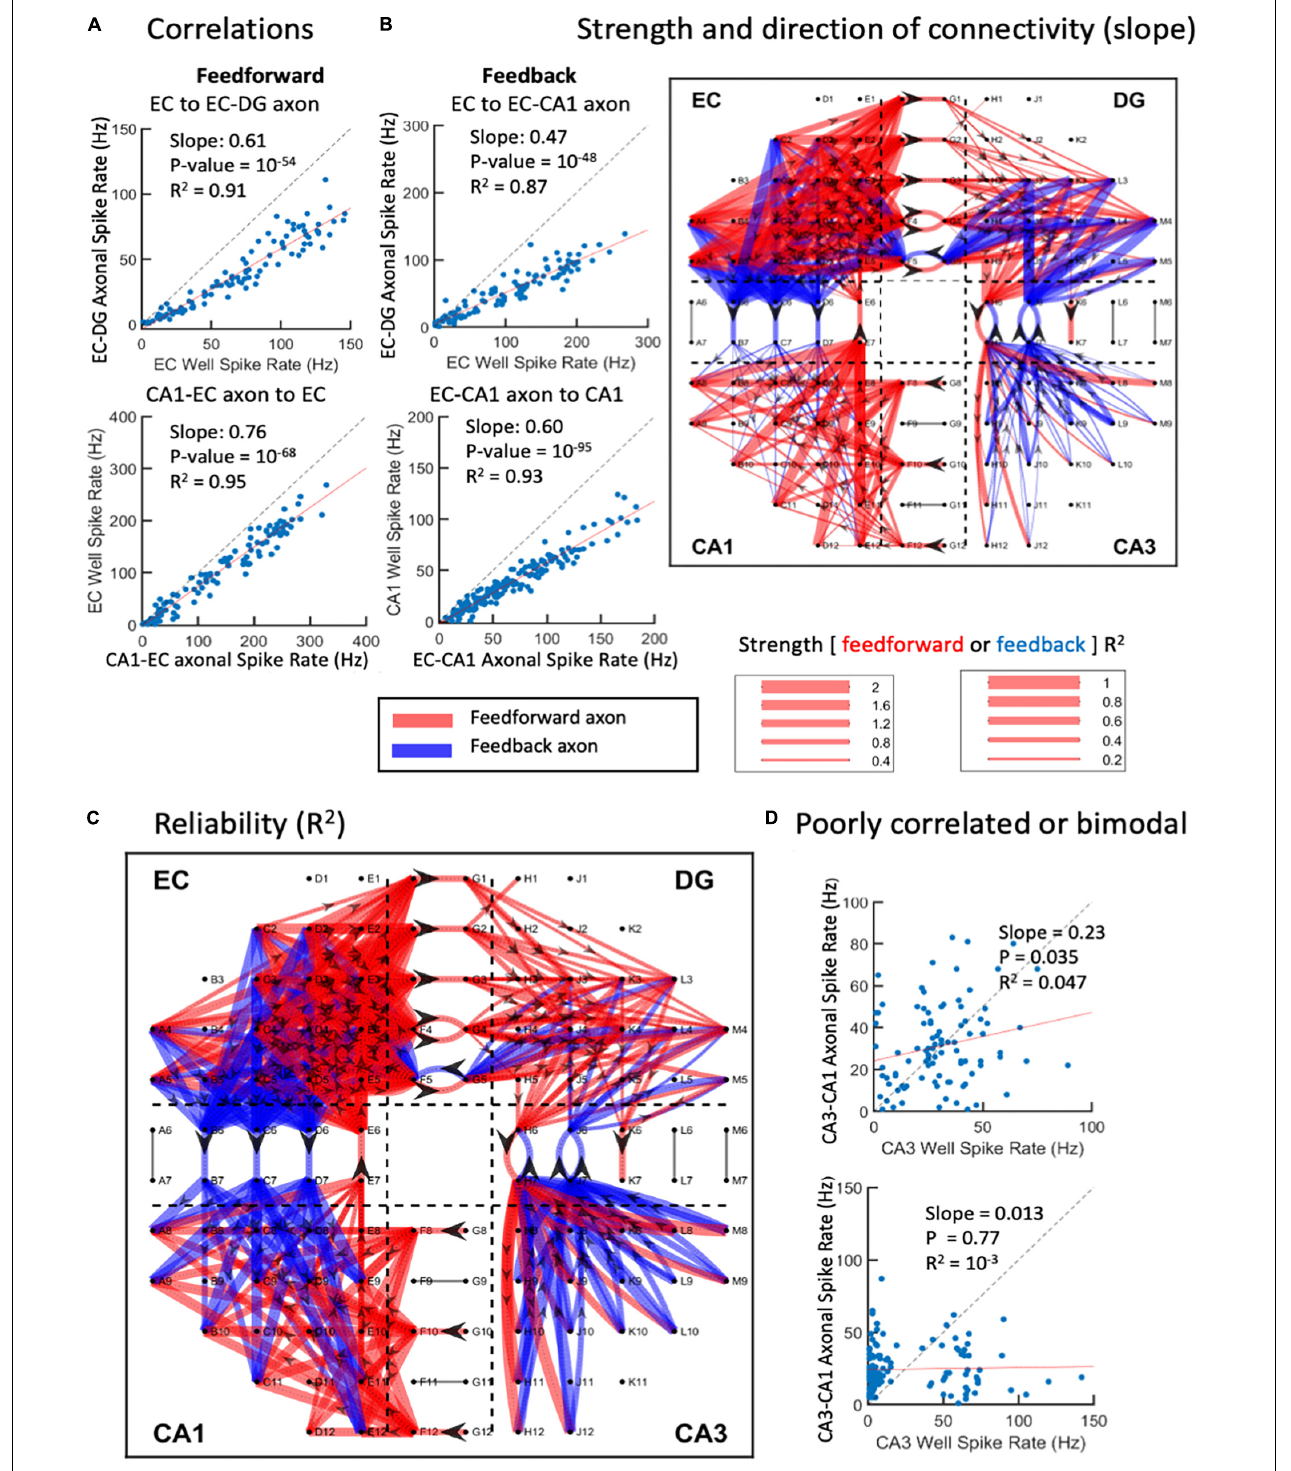
FIGURE 8 | Graphical connections for one-network microelectrode array (MEA). (A) Spike rate correlations between source wells feed-forward to axons in tunnels or feedback from wells to axons. Each point is the spike rate for a 1-s window over the 300-s recording. Top two examples show strong source to axon correlations below unity (dashed line). Bottom two examples show axon to target correlations. (B) Magnitudes of slopes > 0.2 and R 2 > 0.1. Feed-forward is in red, feedback in blue. Directionality indicated by arrowheads in axons. (C) Reliability of connections as correlation coefficients (R 2 ). (D) Examples of poor correlations of CA3 neuron sources to CA3-CA1 axons. Bimodal distribution of CA3 activity in lower example (array 5).